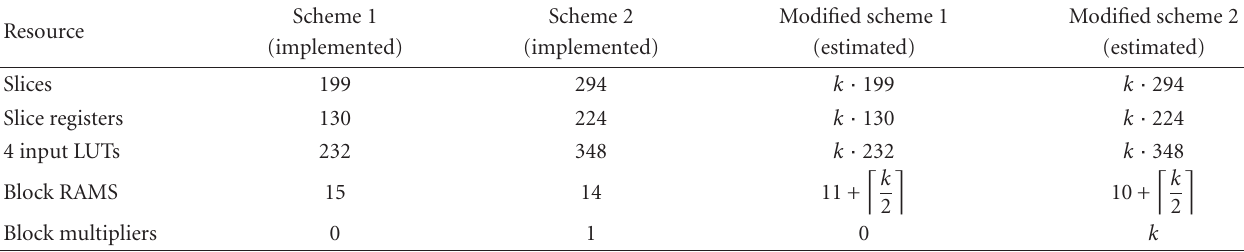
Table 3: Resource utilization for the two schemes on the XC2VP50- ff 1152 device.